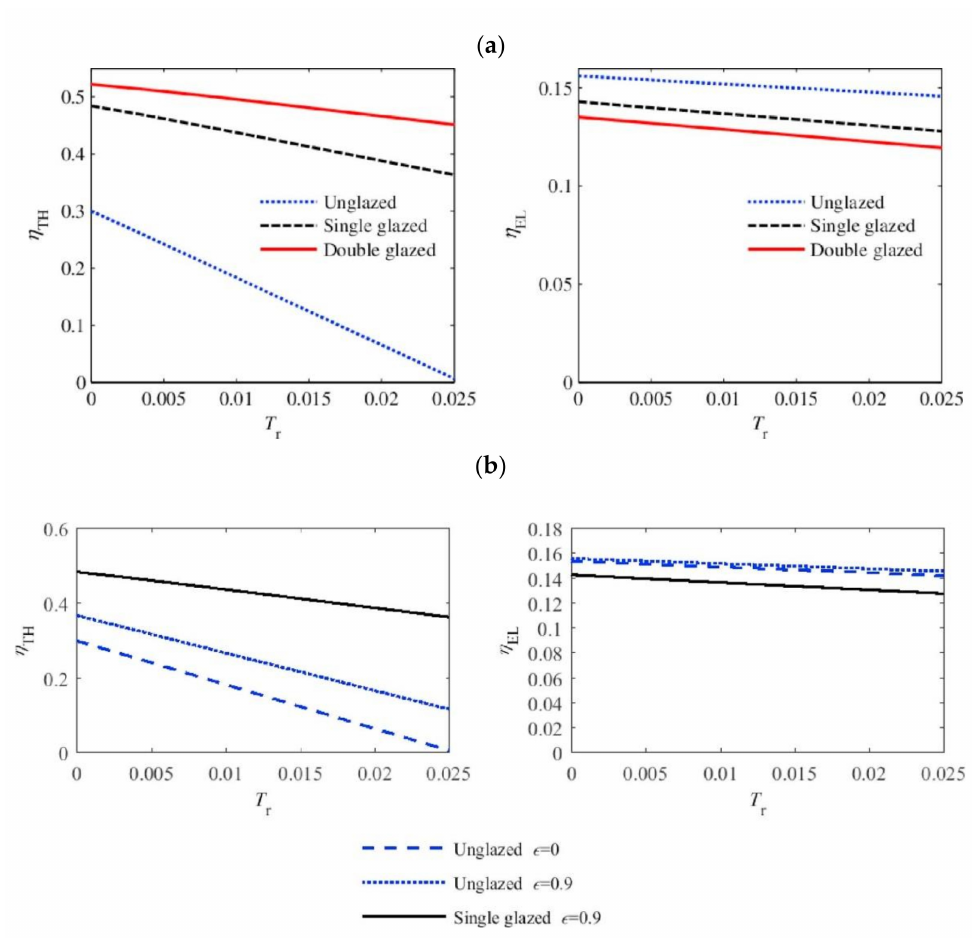
Figure 21. ( a ) Thermal and electrical efficiency of PVT for different covering on the top, ( b ) thermal and electrical efficiency of PVT for different cell emissivity values and covering on the top (reprinted from [115], with permission from publisher).